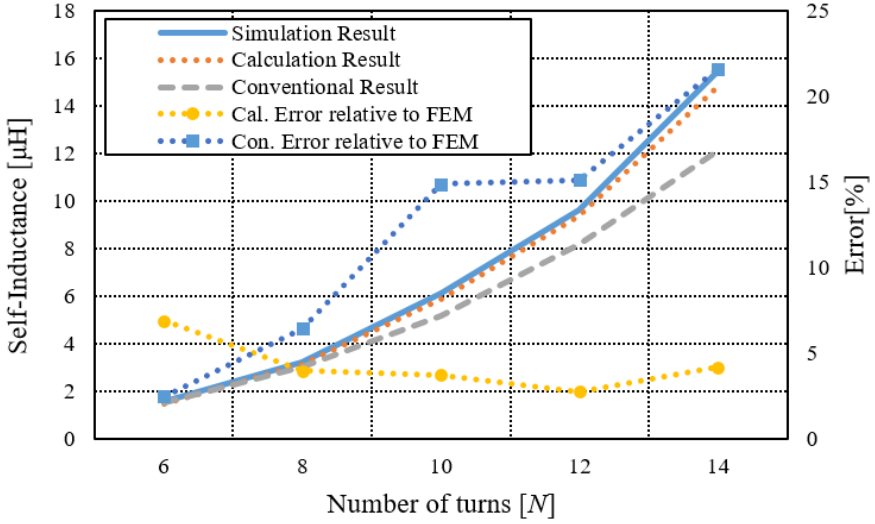
Figure 5. The effect of the change of the number of turns on the inductance of the spiral coil.